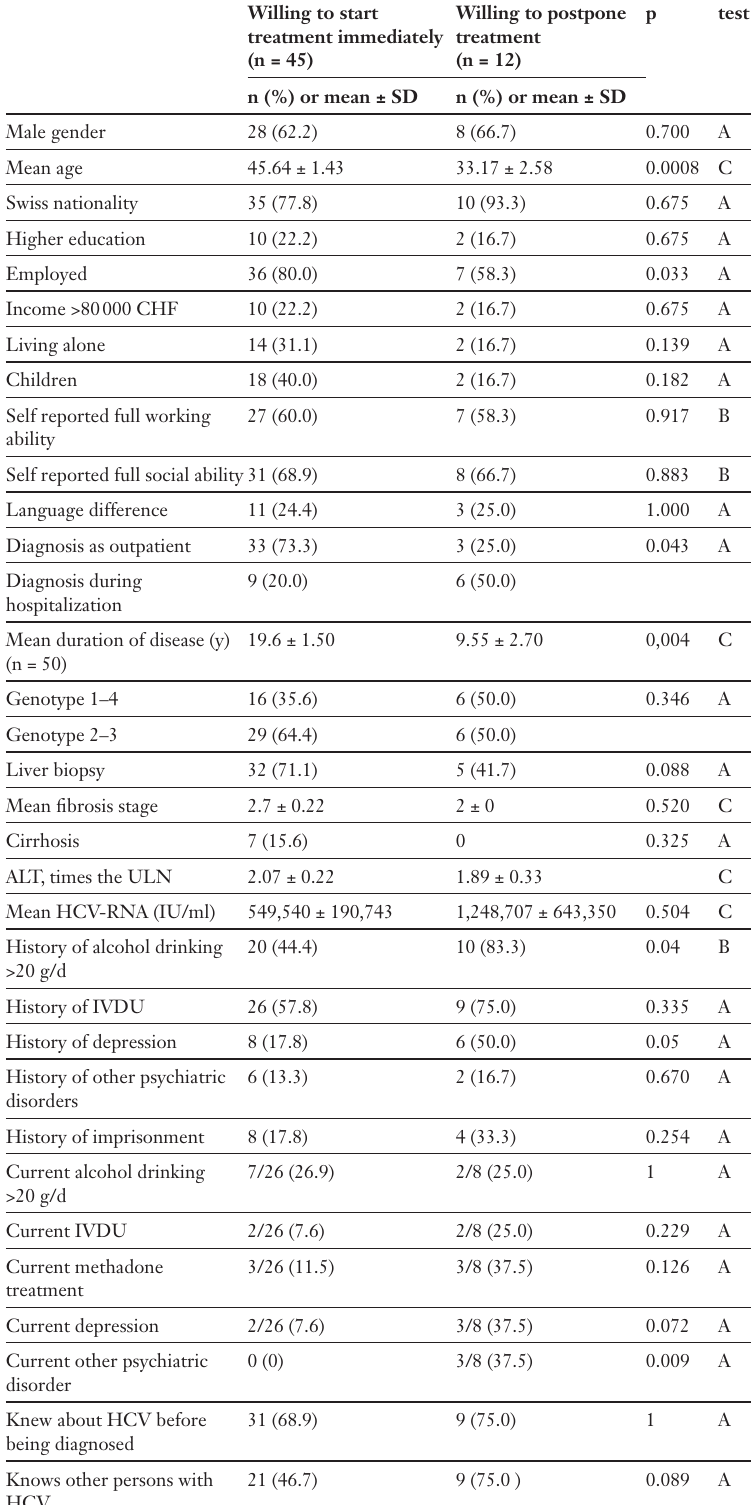
Univariate analysis: Comparison of treatment readiness.